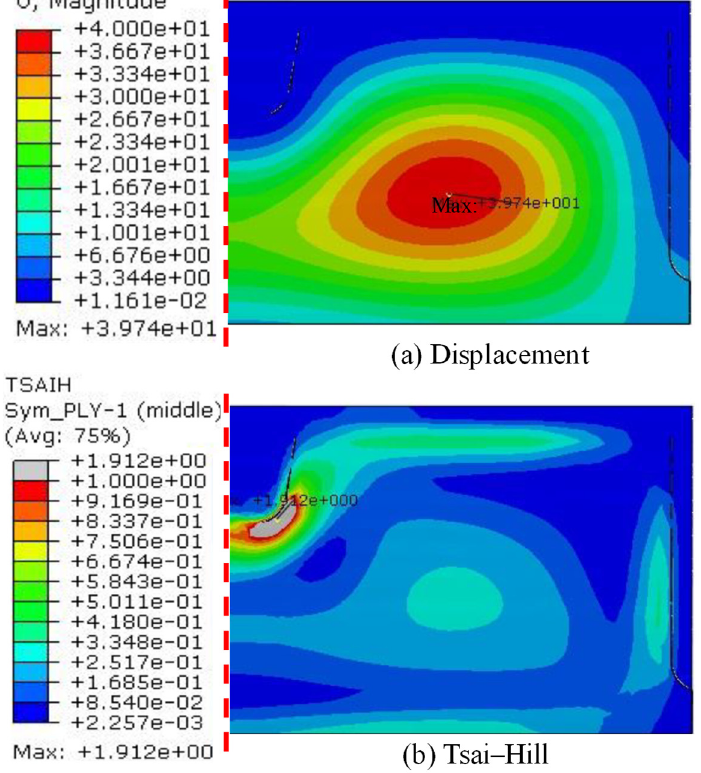
Figure 5. ( a ) Displacement (unit in mm) and ( b ) Tsai–Hill index results of coreless spoiler (top view and half-model